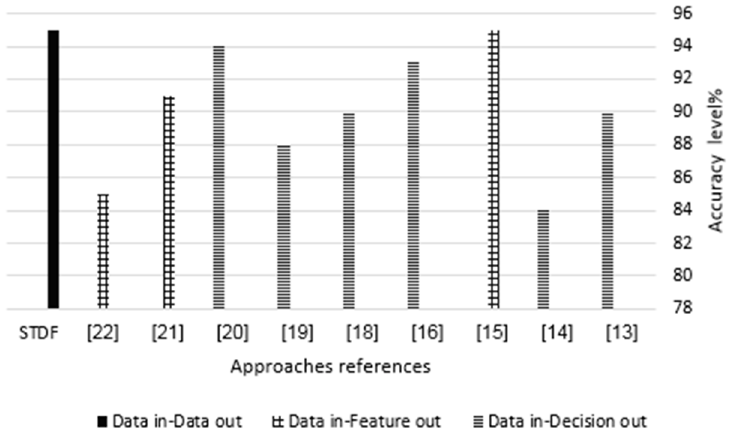
Figure 14. STDF accuracy evaluation.